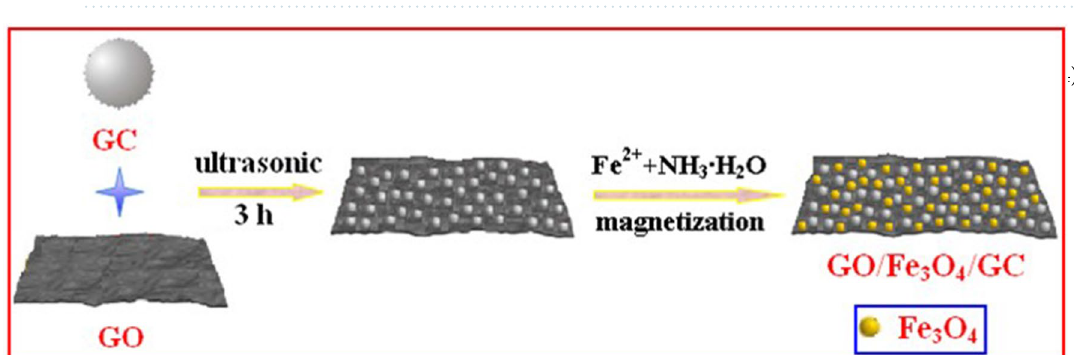
Figure 3. XPS survey spectra of Fe 3 O 4 , glucose, GC, MGC and GO/Fe 3 O 4 /GC ( A ) and the high-resolution Fe 2 p spectra of Fe